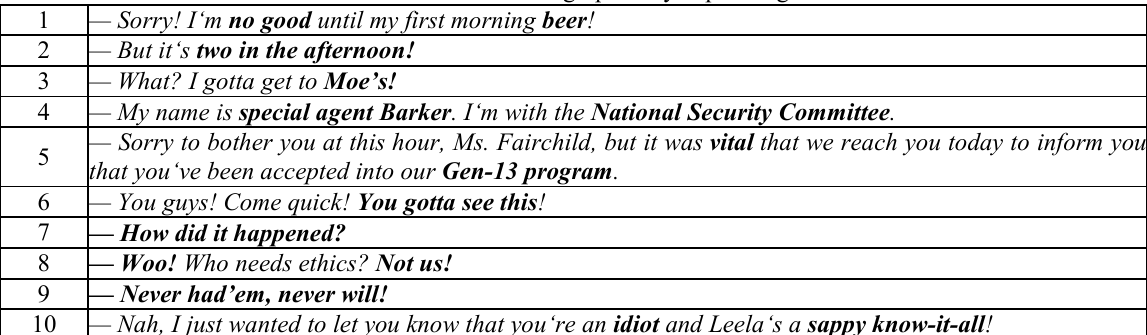
Table 2. – Means of graphically expressing